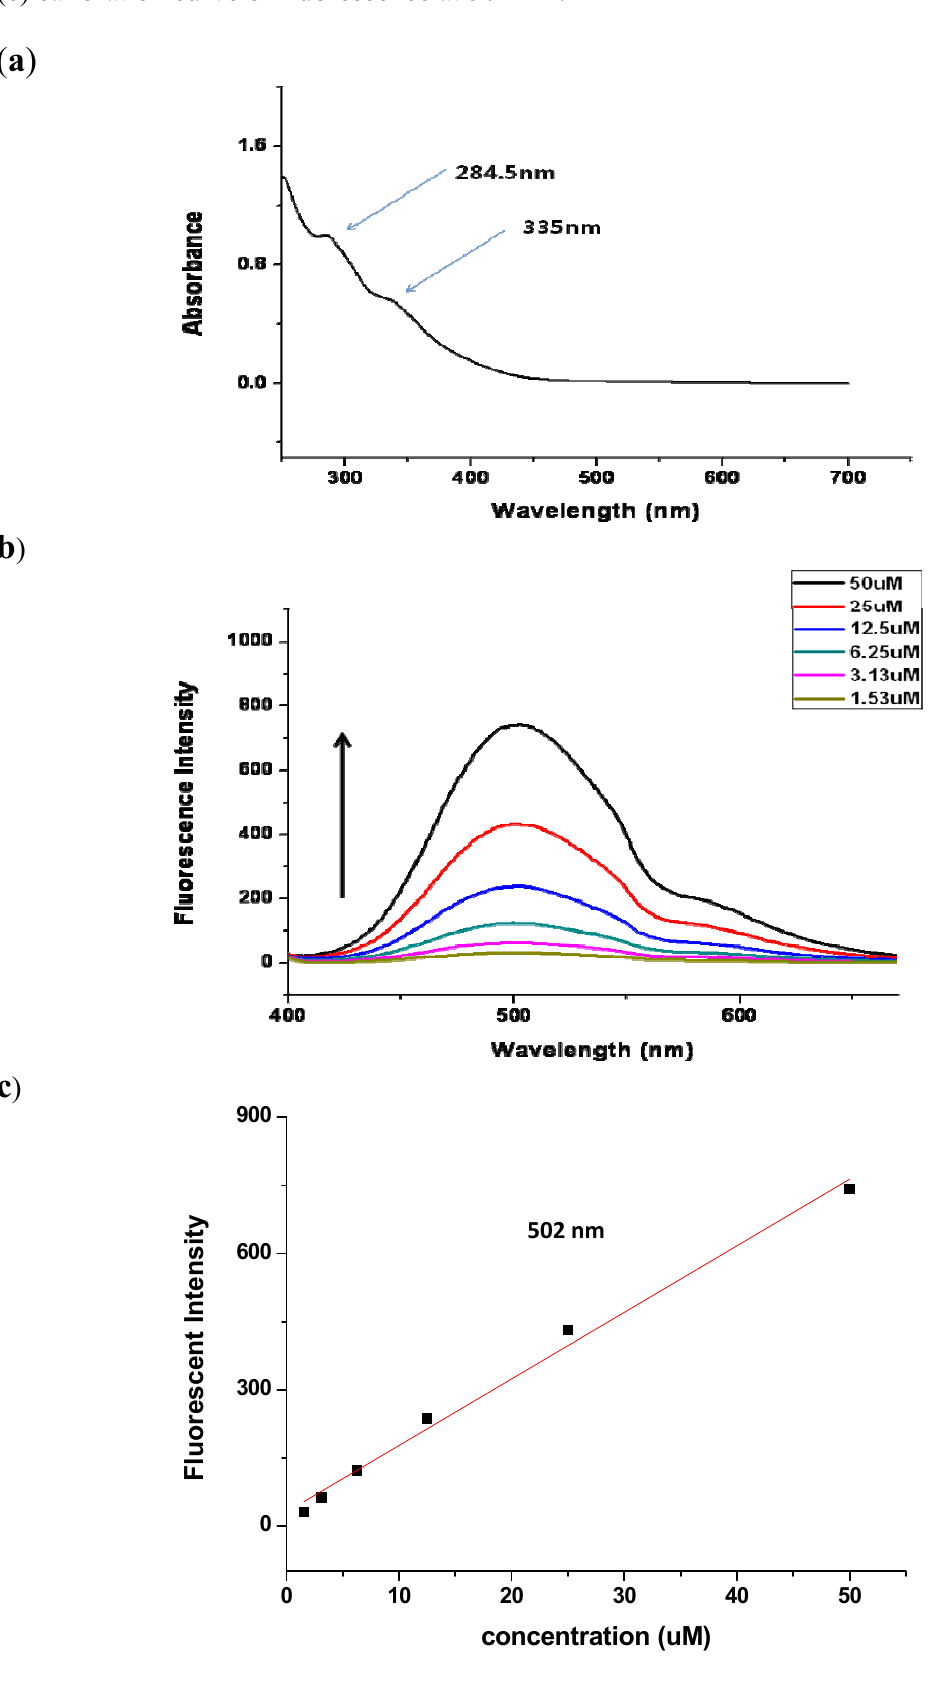
Figure 2. Electronic absorption and emission spectra of dual-functional DLB probe 3